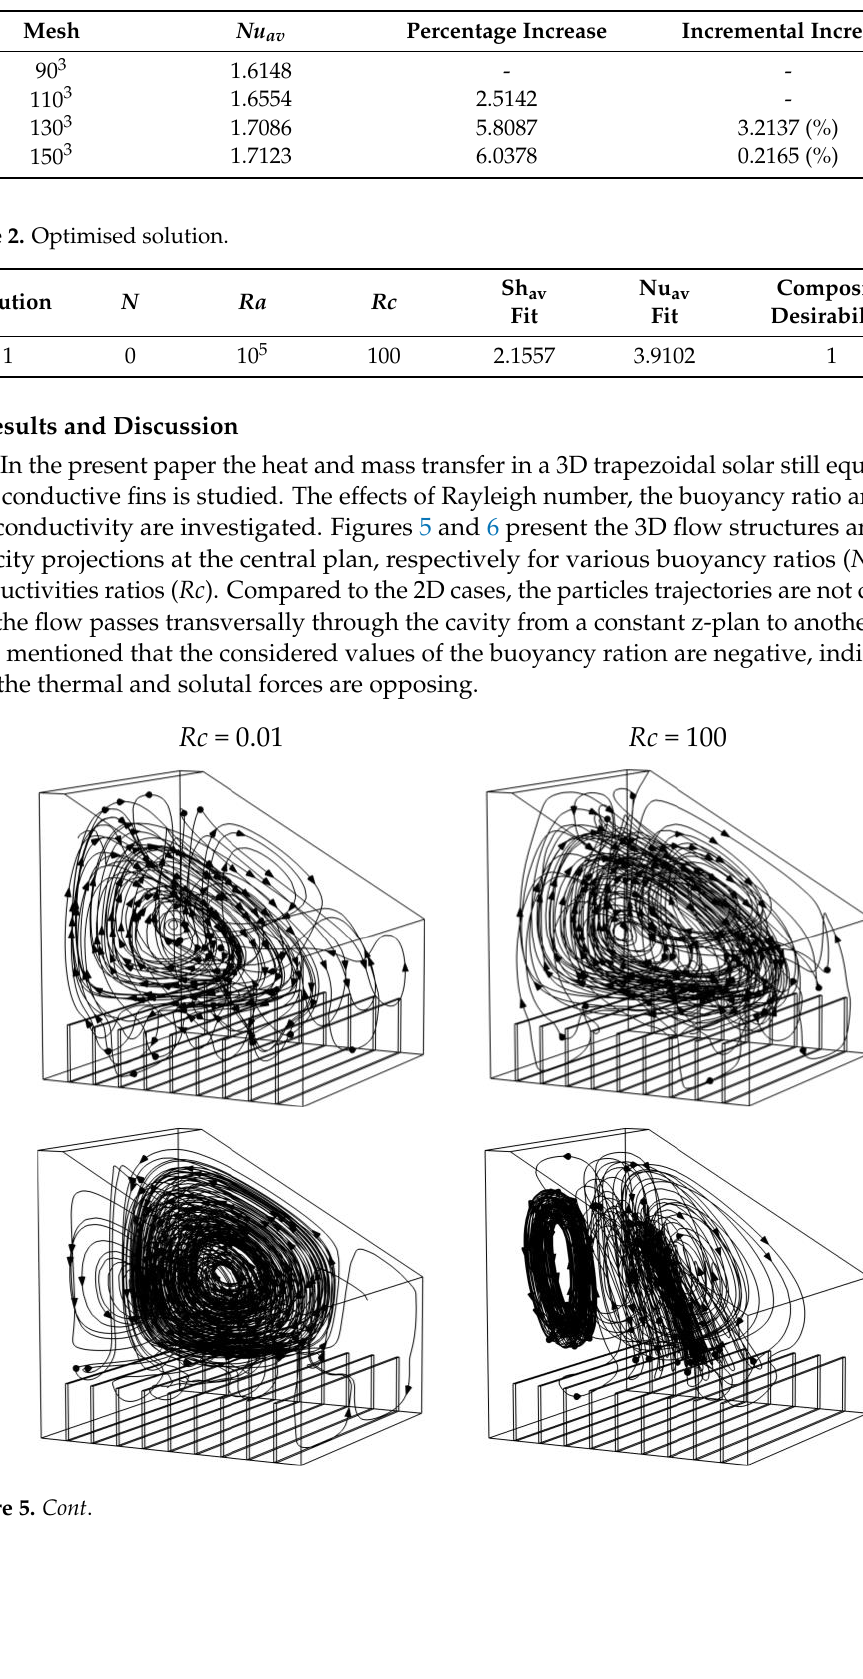
Table 1. Mesh sensitivity test.